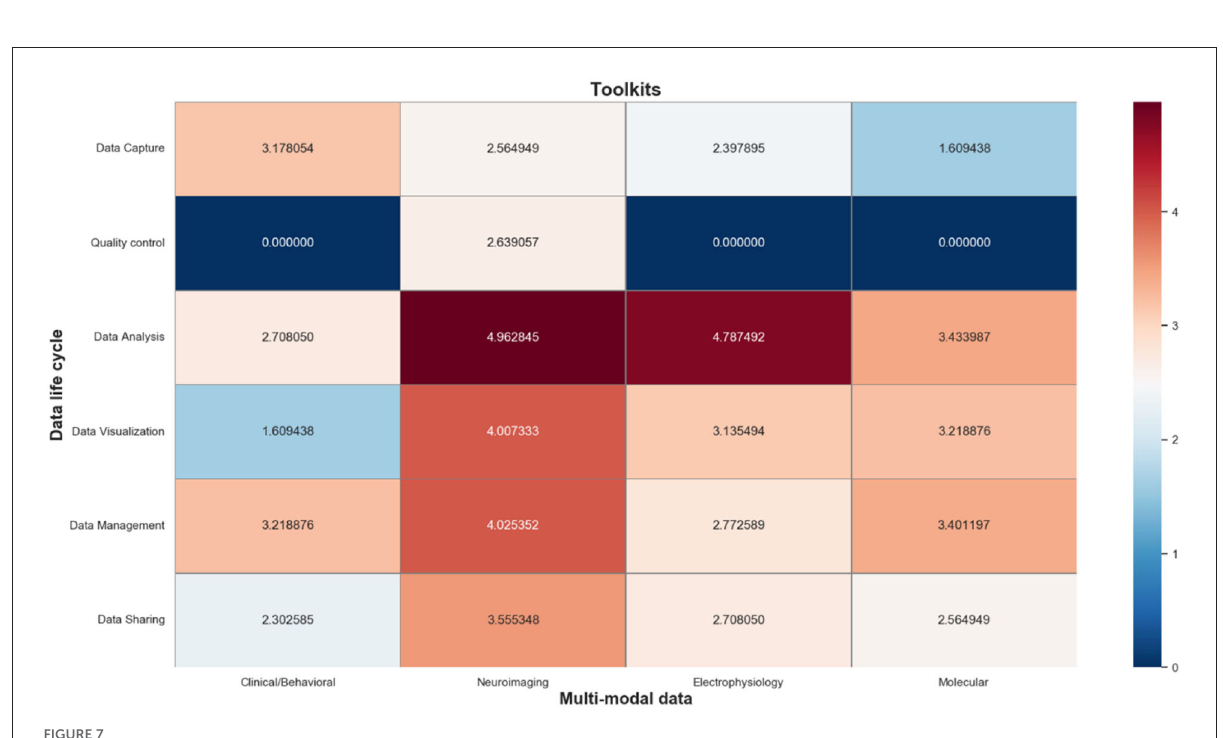
FIGURE7 Heat map of information